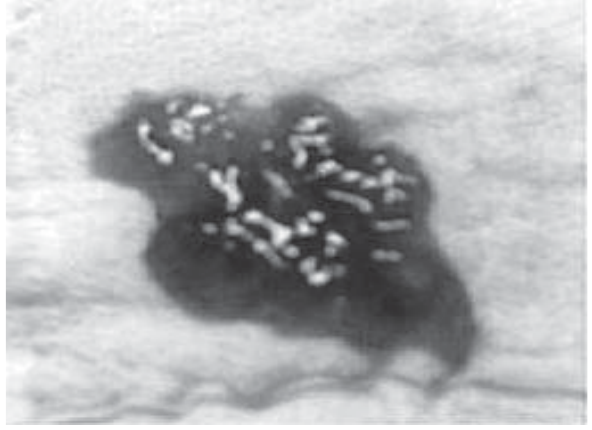
Fig. 1 - Aparência macroscópica do mixossarcoma atrial